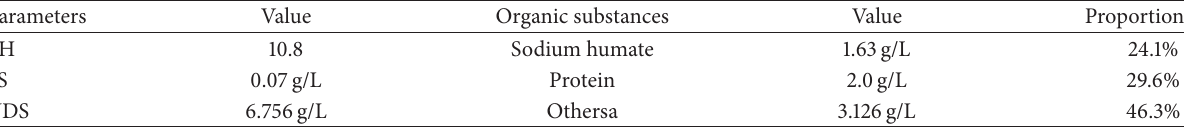
Table 1: Characteristics of the supernatant after alkaline treatment.